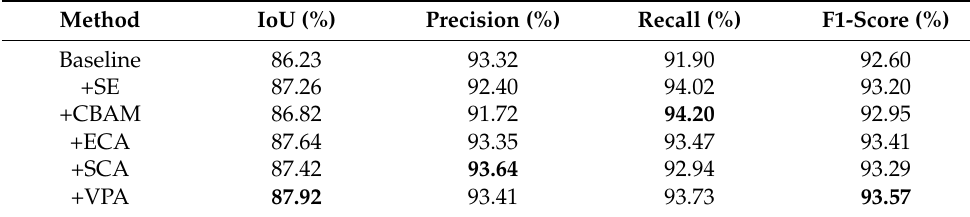
Table 4. Experimental results on the WHU Building dataset. The bold indicates the best data.